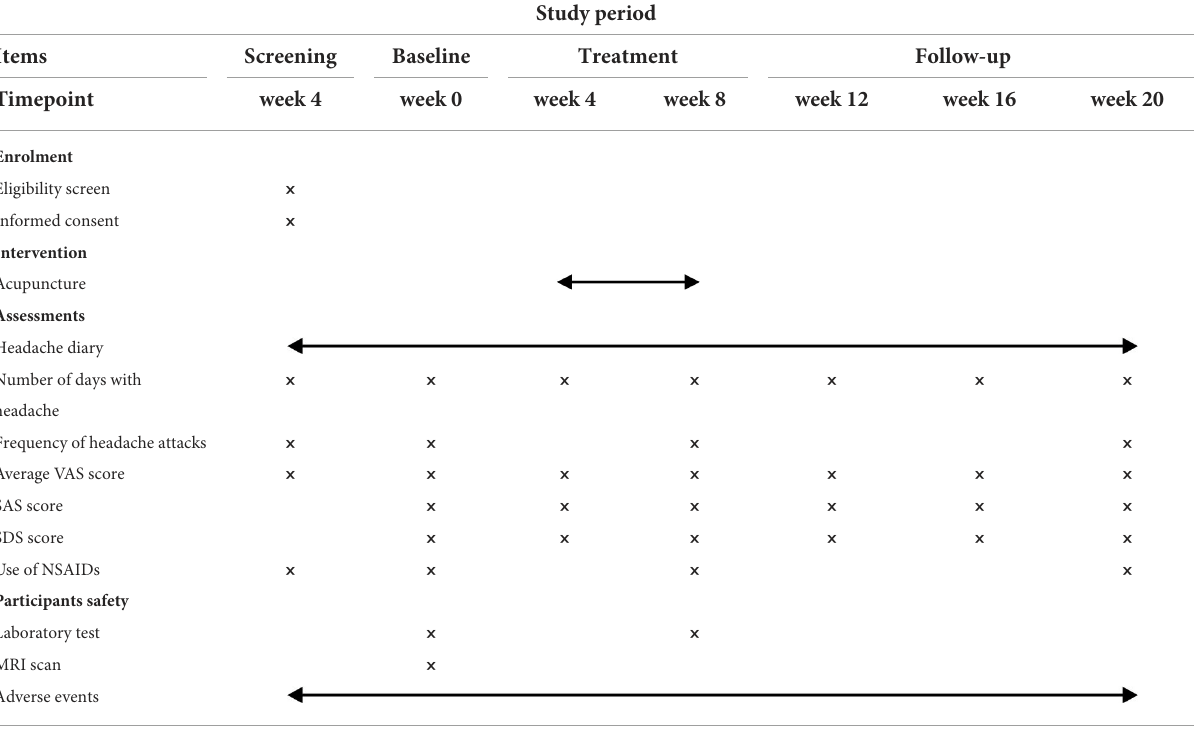
TABLE 1 Standard protocol items: recommendations for interventional trials (SPIRIT) schedule of the trial.